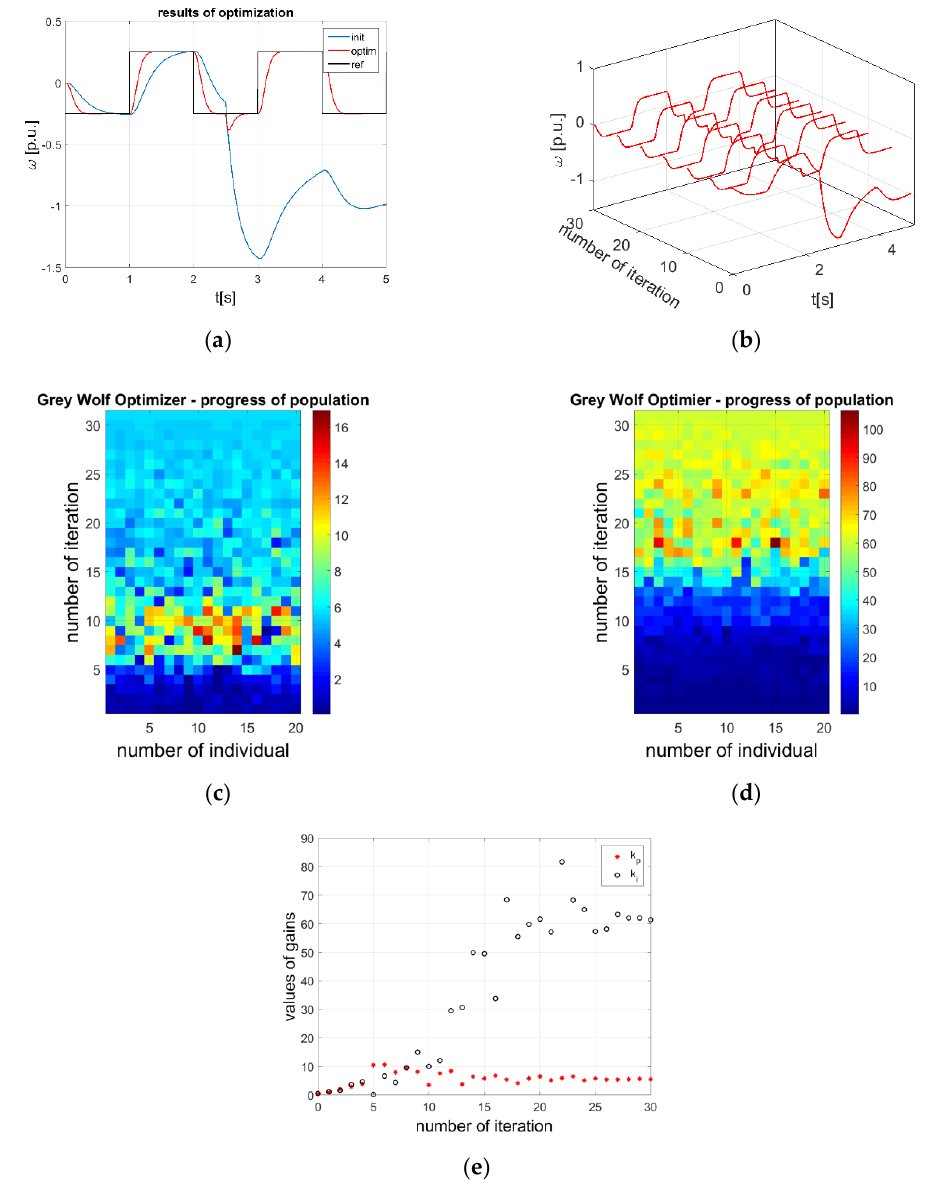
Figure 3. Results of data processing in optimization process—initial and final results ( a ), transients of speed in selected steps ( b ), changes in wolf population in searching for k p ( c ), changes in wolf population in searching for k i ( d ), and fluctuation of optimized parameters ( e ).